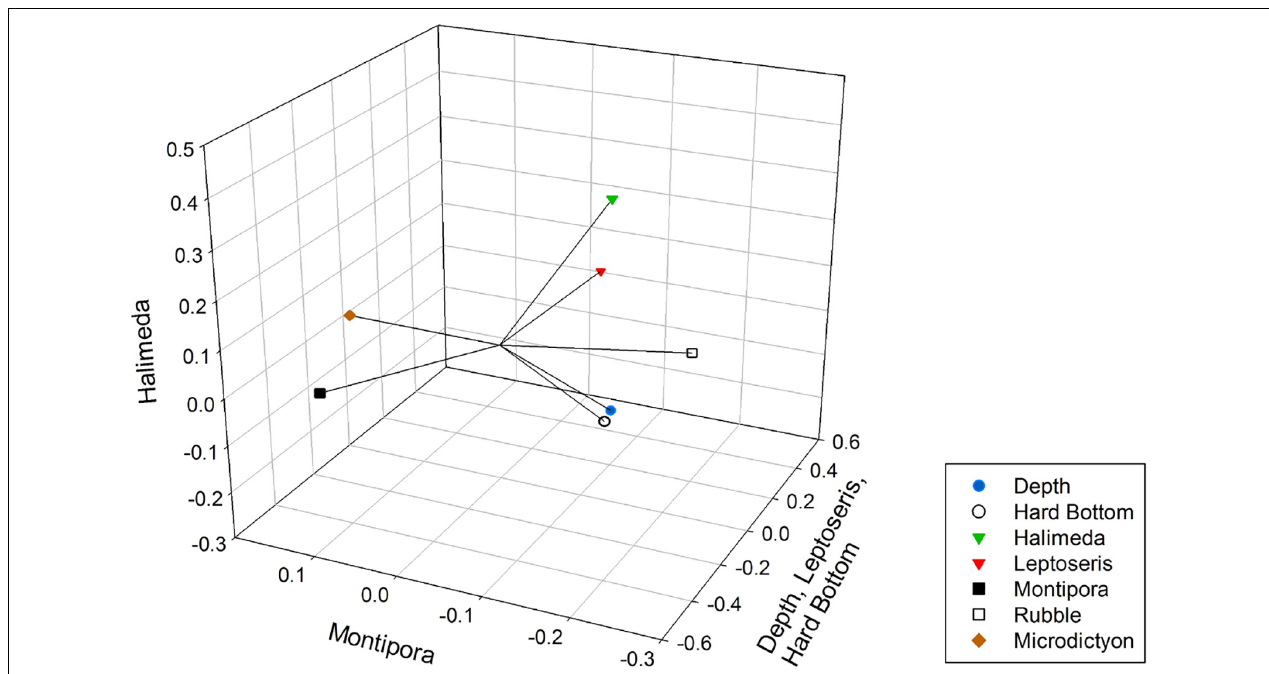
FIGURE 4 | Non-metric Multidimensional Scaling plot of environmental variables, showing their Kendall Tau correlations with the three axes (vectors). Axis one is correlated with depth, Leptoseris and hard bottom. Axis two did not correlate with any substrate and axis three correlated with Halimeda.